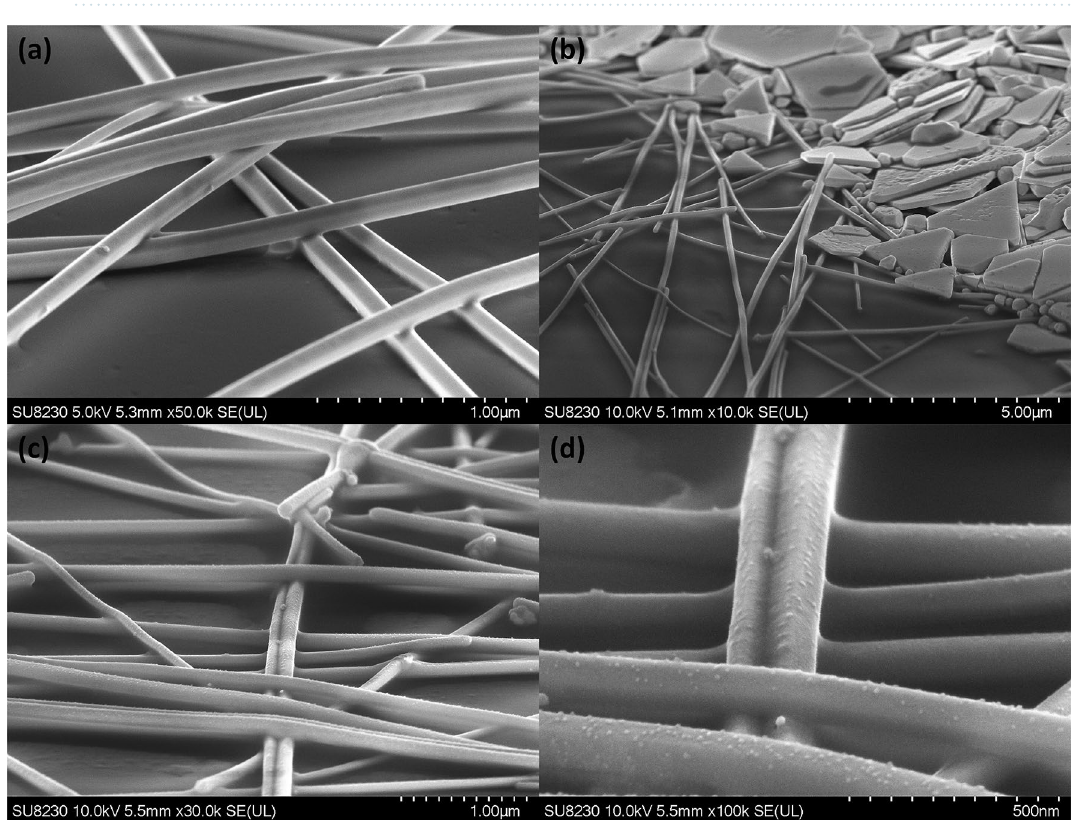
Figure 3. SEM images of the nanowires before and after photonic treatment ( a ) Pristine untreated nanowire films ( b ) Photonic-treated films showing the interface with the silver flakes from the electrical contacts ( c , d ) High-resolution micrographs to highlight the successful interconnection of the nanowires yielding better electrical properties after photonic Fig. 4a for samples with 1–4 layers, and using pristine glass as the baseline. Averaging the TCE transmittance values over the visible spectrum (400–800 nm), we obtain 91.5%, 88.3%, 82.8% and 74.7% for samples with 1, 2, 3 and 4 nanowire layers respectively. Haze is another optical parameter that provides information about the light scattering in the film and points to the utility of a TCE in diverse applications. Haze values lower than 1% make TCE’s very useful for display applications whereas higher values highlight their utility in photovoltaic devices 48 . Our champion sample made with 2 layers, presents an average haze over the visible range of 16% before photonic treatment and 16.9% after, shown in Fig. 4a. Even with the change in NW’s texture after treatment shown in Fig. 3d, its haze remains close to its initial value and demonstrates potential use in photovoltaic devices. Finally,